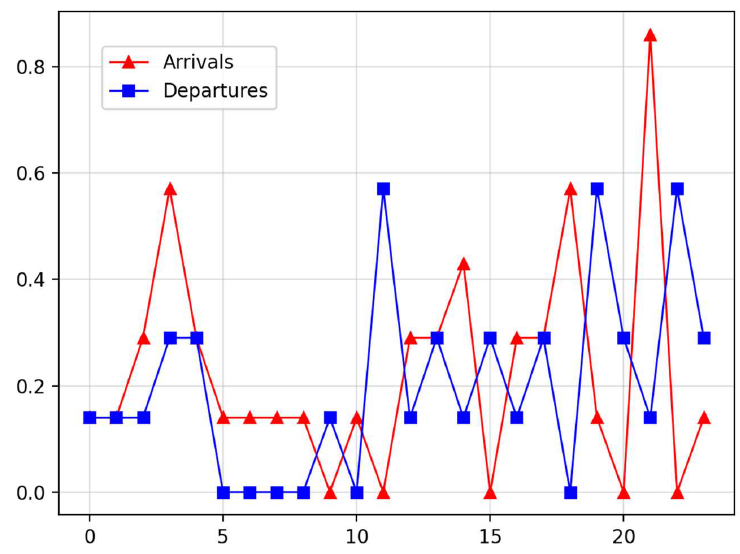
Figure 11. A line chart of the ship arrivals and departures at Wuhan Port for one day. Figure 12 shows the line chart of the ship arrivals and departures at Chongqing Port for one day. The peak and trough periods of the arrival and departure times at Chong- qing Port and Shanghai Port were almost the same. These peaks and troughs appeared more extreme, with more ships arriving and departing during peak periods and fewer troughs.